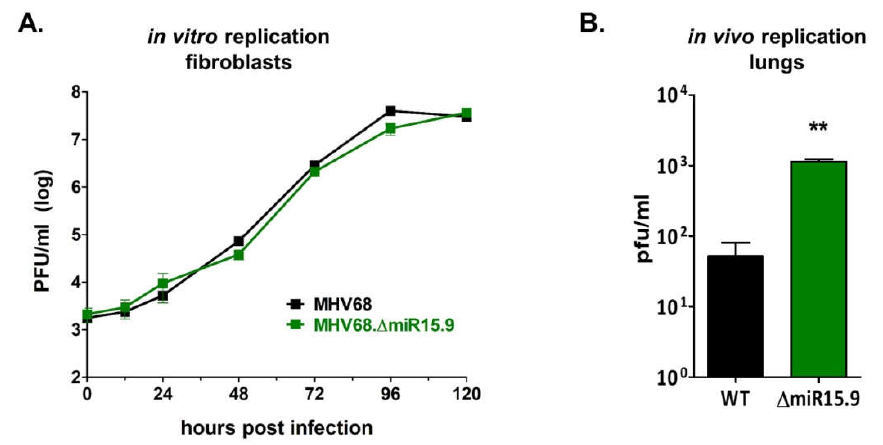
Figure 8. MHV68 mutant deficient in pre-miRNA-15 and pre-miRNA-9 replicates normally in vitro but demonstrates increased lytic replication in vivo. ( A ) Lytic replication in fibroblast cells in vitro was determined using multi-step growth curve. NIH 3T12 fibroblasts were infected with MHV68 or MHV68 ∆ 15.9 at MOI 0.05. Samples were then harvested at 12 to 24 hr increments and subjected to plaque assay to determine viral titer. Values represent the mean titer ± standard deviation (SD) ( n = 3). ( B ) In vivo replication in lungs of wild-type mice was quantified by plaque assay. Eight mice per sample group were inoculated intranasally (i.n.) with 10 4 PFU wild-type MHV68 (WT) or MHV68 ∆ 15.9 ( ∆ 15.9). At 5 dpi lungs were harvested and virus titers were determined by plaque assay. Values represent mean titer ± SD. ** p < 0.01 using an unpaired t -test.